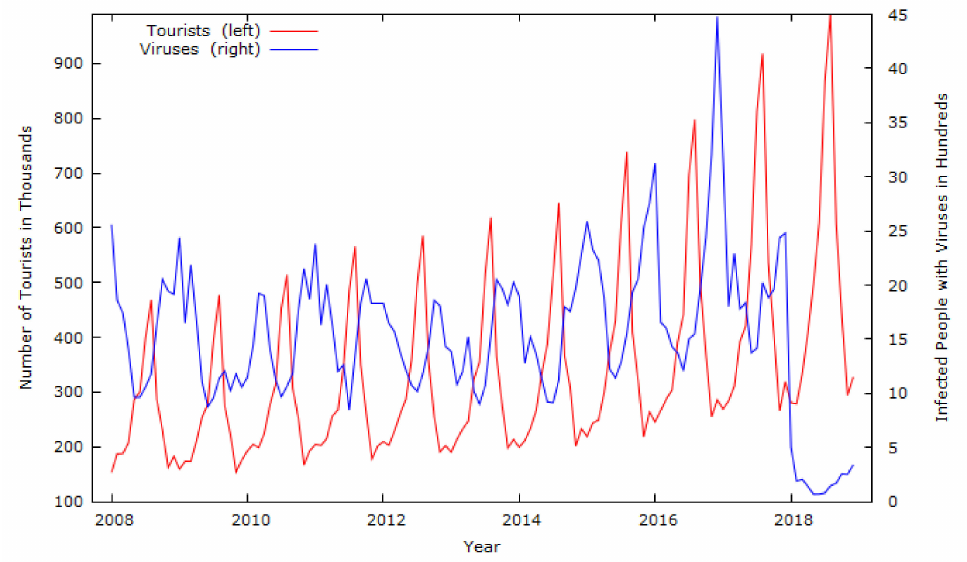
Figure 1. Data in levels for tourist arrivals and viruses from January 2008 to December 2018. Source: Authors calculations